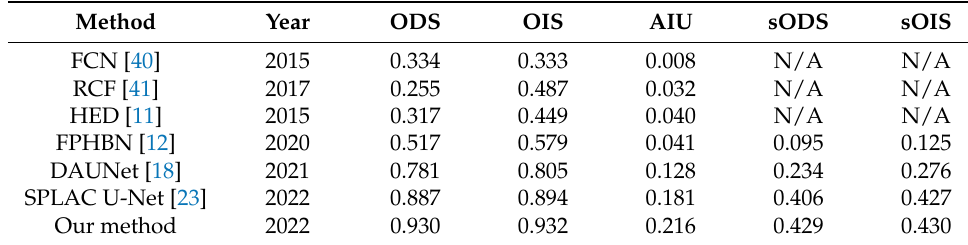
Table 2. Segmentation performance comparison results on Cracktree200 dataset.